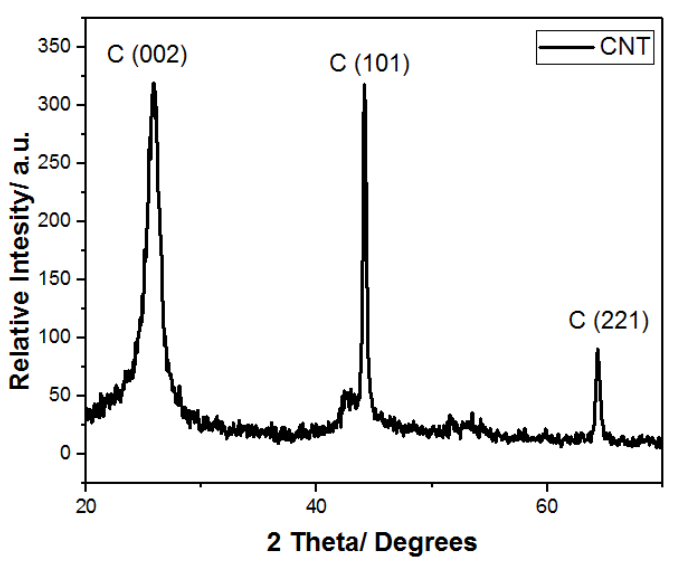
Figure 10. XRD of purified CNTs.